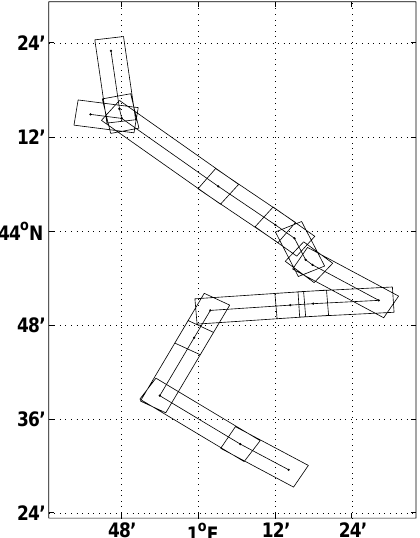
Fig. 4. Segment areas along two schematic flight tracks for extract- ing land-use information from land-use map (see Fig. 2) for seg- ment 3 to 12. Each area is build from its corresponding segment length (or sub-segment lengths with overlap removed) with a mar- gin of 3km all around